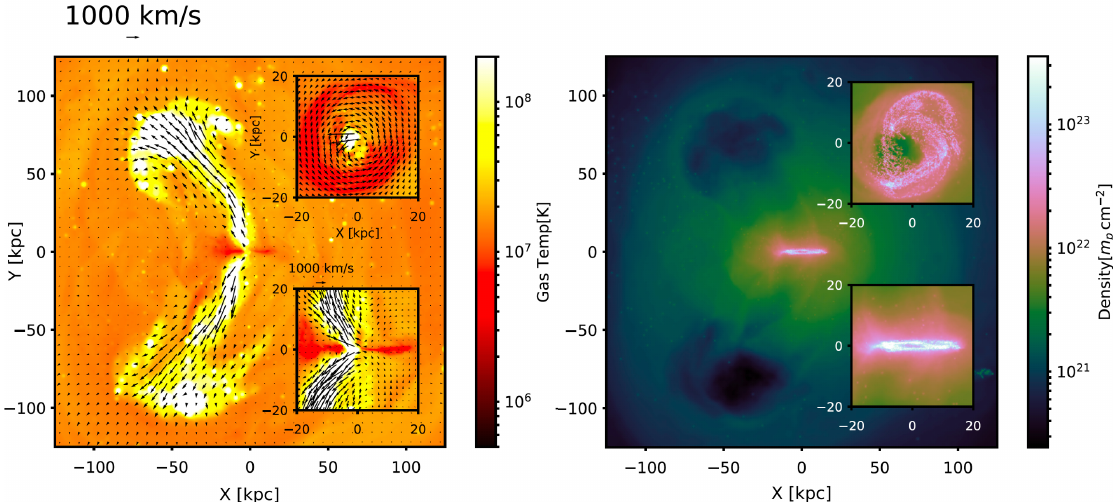
Figure 7. Wind-blown bubbles driven by AGN feedback from the central galaxy in the ROMULUSC simulation at z = 0.53, adapted with permission from Tremmel et al. [49]. This M 500 = 10 13.6 M group produces a cool core that is elusive in (cid:12) other simulations, although the central gas densities are high compared to observations. This AGN feedback is a thermal dump model without explicit collimation, and is the most obvious example of bubble-driven feedback at the group scale found in the cosmological simulations we